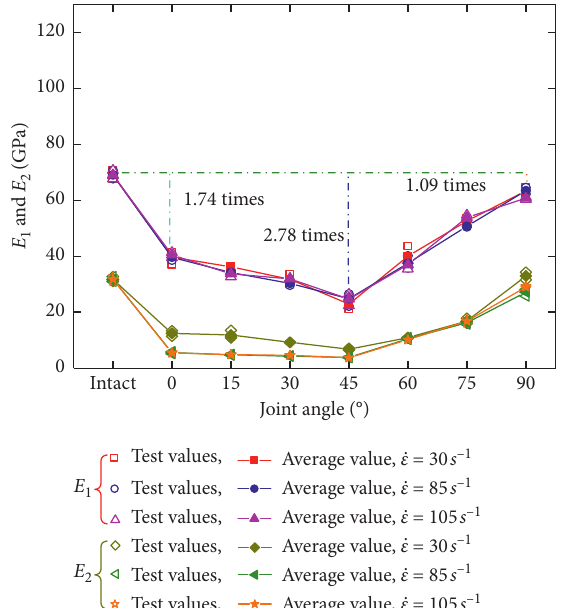
Figure 8: The variable tendency of E under three different strain